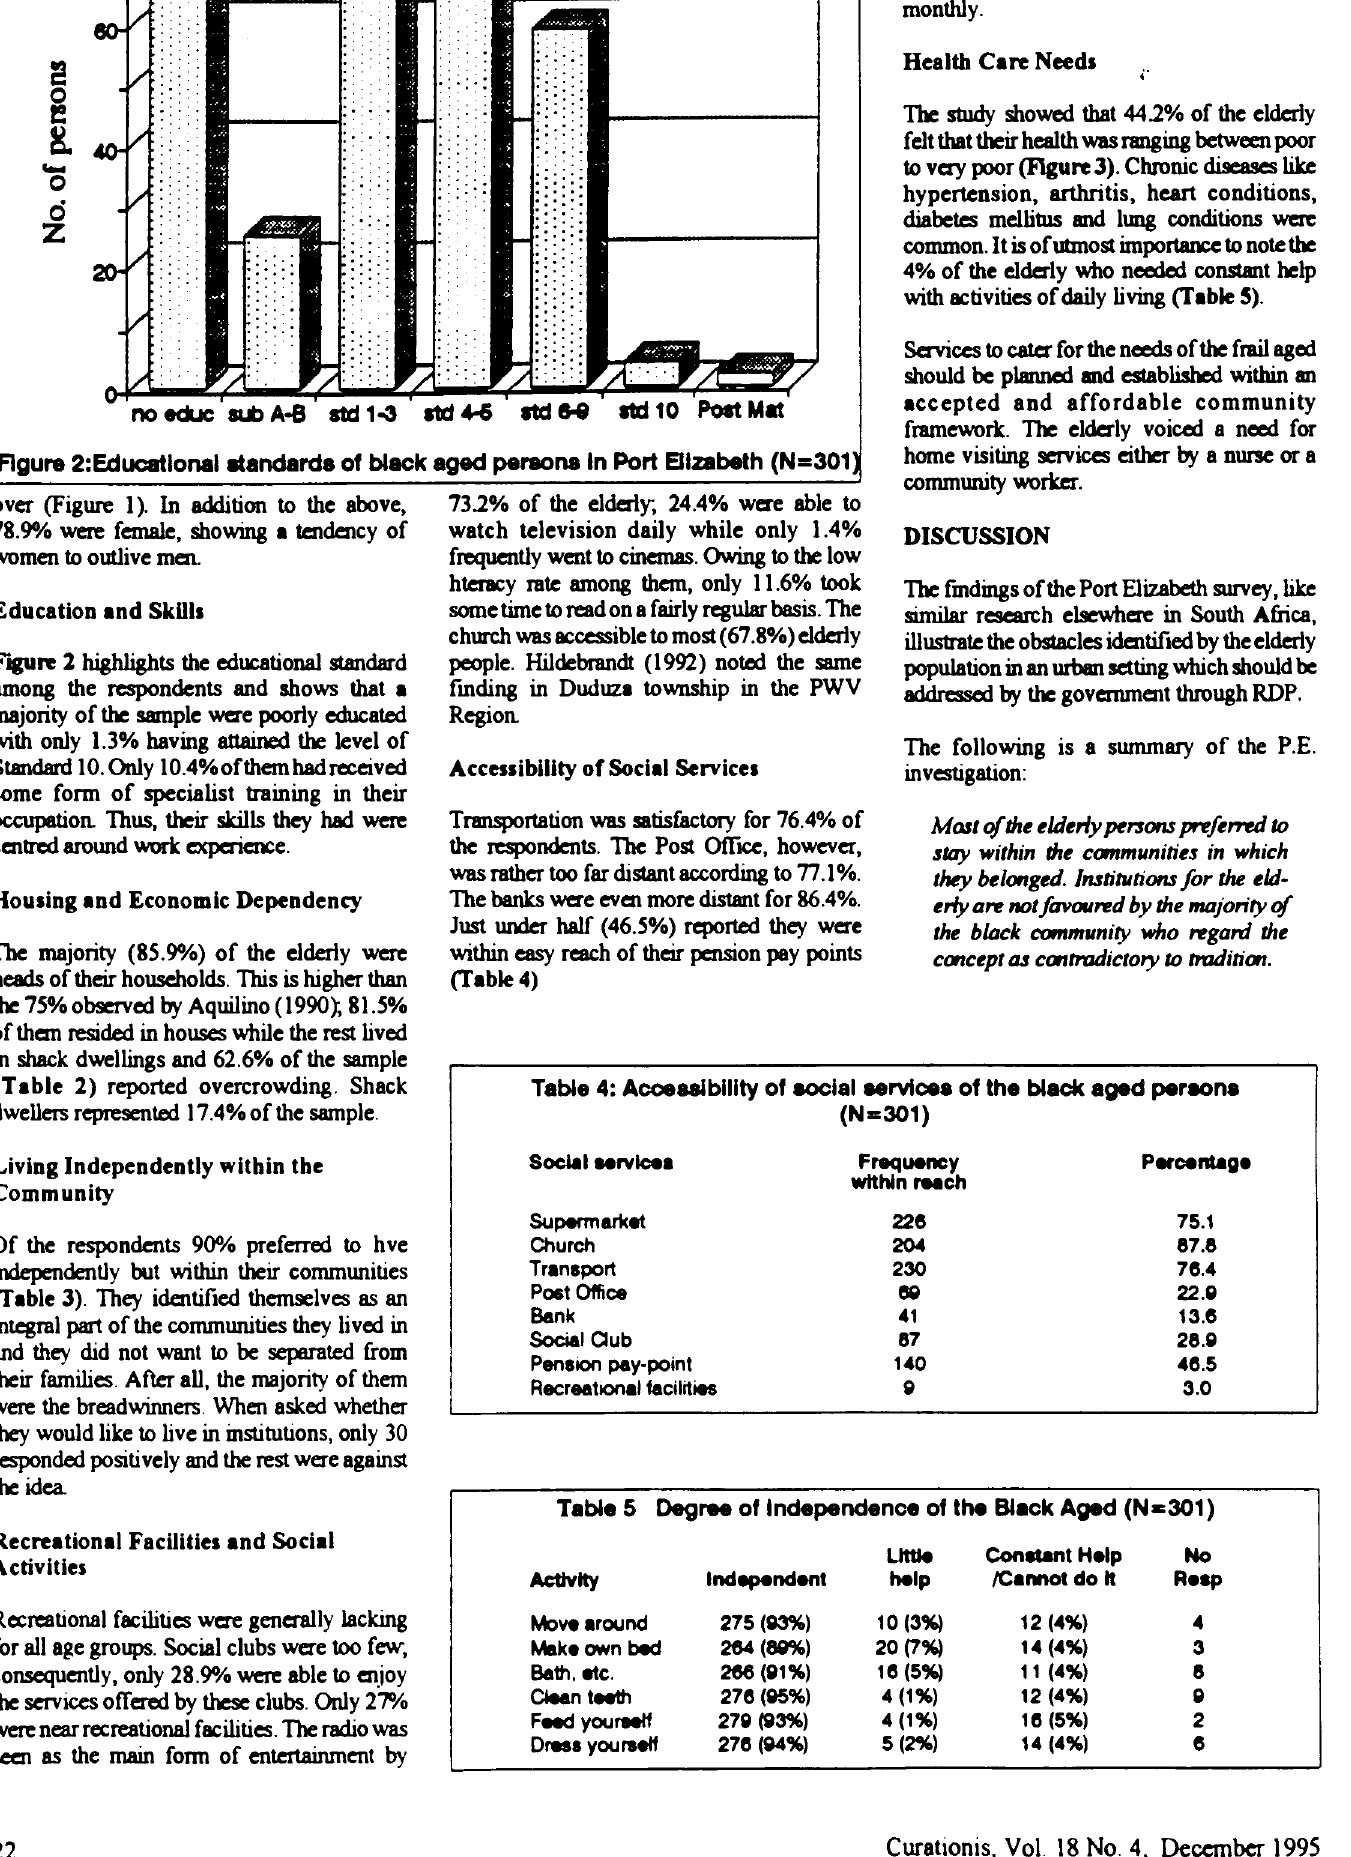
Rgure 2:Educatlonal standards of black aged persons In Port Elizabeth (N=301 over (Figure 1). In addition to the above, 78.9% were female, showing a tendency of